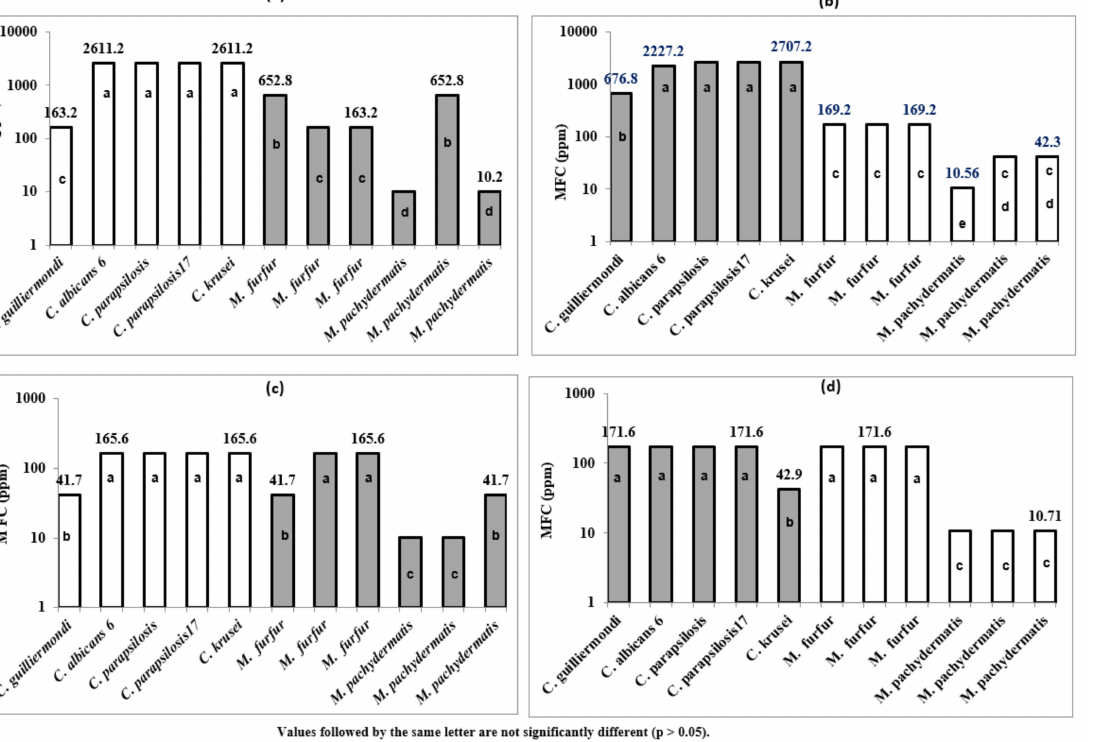
Figure 4. MFC values (ppm) of antifungal activity of the EOs of D. triradiata : roots ( a ), seeds ( b ), stems ( c ), and flowers ( d ) against selected strains from two fungus genera Malassezia (6 species) and Candida (5